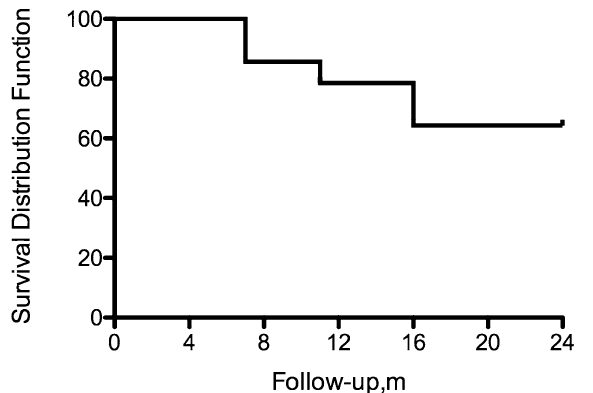
Figure 1. Kaplan–Meier survival curve showing the risk of clinical progression. At 1 year, 73.3% of RIS patients have not experienced CIS/MS conversion. At 2 years, 66.6% of patients have not progressed. This image was generated using Prism (Version: 5, Url: https ://www.graph